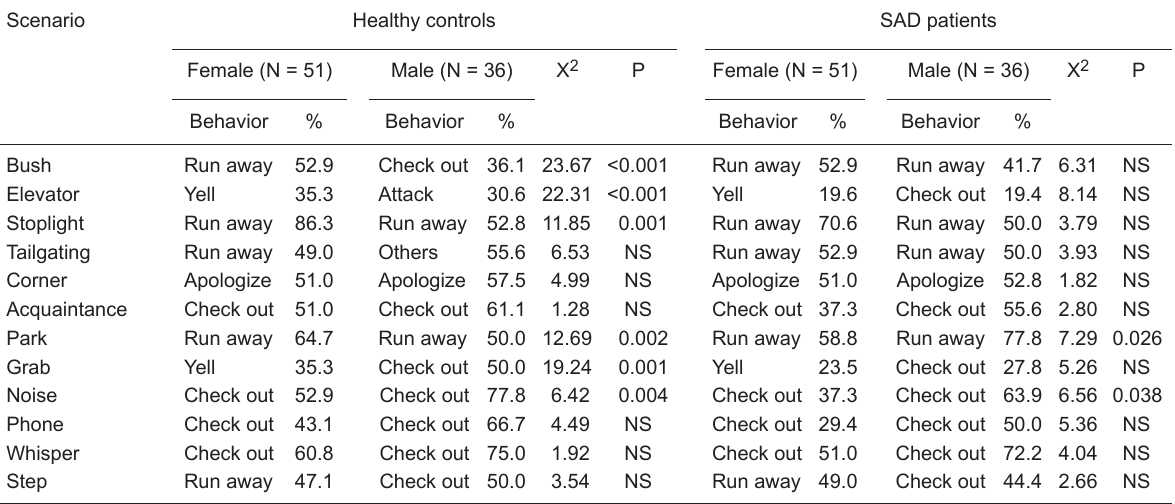
Table 3. First-choice response rate to each scenario made by SAD patients and gender- and age-matched healthy controls.